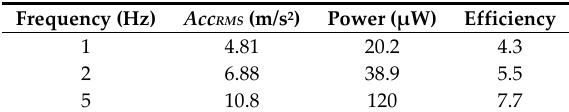
Table 1. Performance of the harvester with compensation mechanism in case of the minimum acceleration assuring the maximum switching